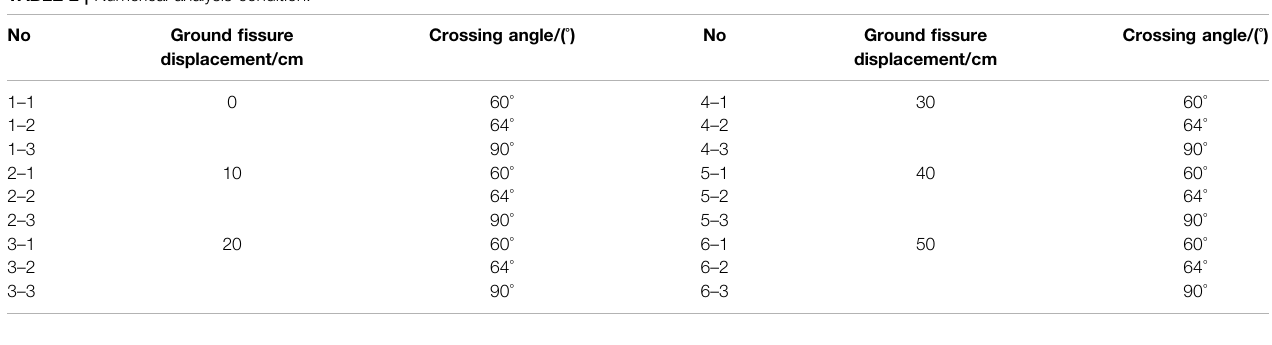
TABLE 2 | Numerical analysis condition.